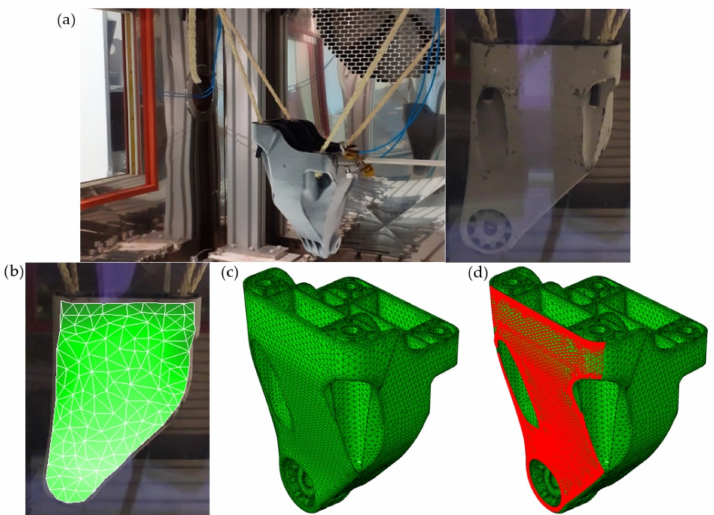
Figure 5. ( a ) Setup for the experimental investigation of the structural dynamics of the engine bracket. ( b ) Experimental scanning point mesh. ( c ) Simulative surface mesh of the engine bracket geometry. ( d ) Evaluation nodes for simulative FRF.